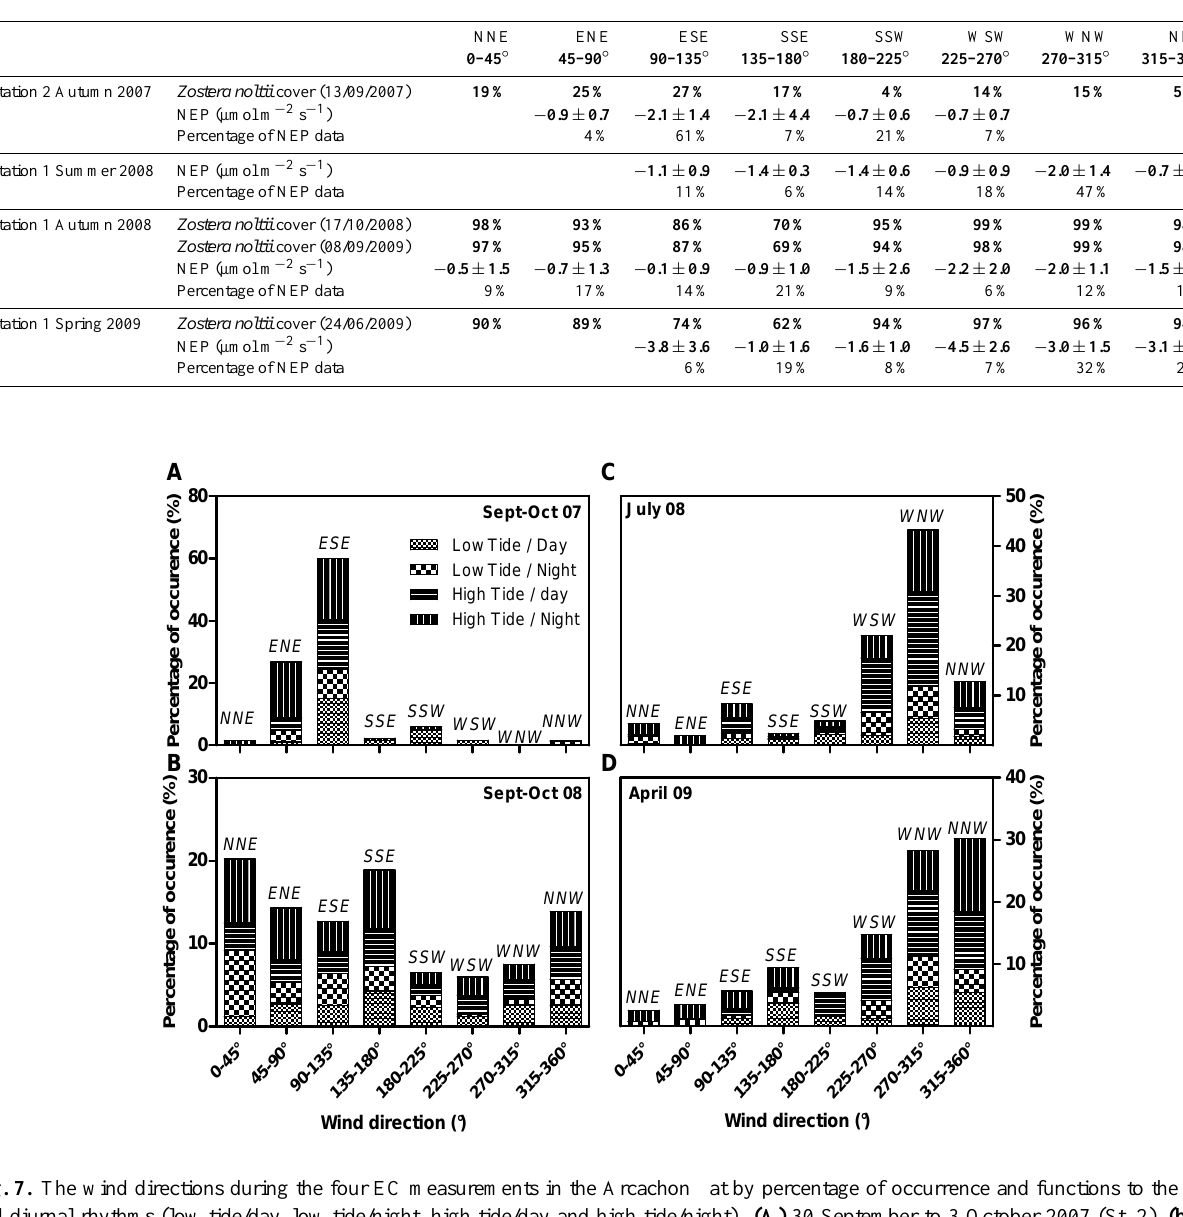
Table 2. NEP values (corresponding to mean LT/Day CO 2 fluxes ± standard deviation) and Zostera noltii covers derived from satellite image analyses from the Arcachon flat, at low tide during the day, according to sectors of wind direction (circle of 1000m radius around the mast and split in 32 sectors of 11.25 ◦ ). No satellite image matching with the deployment in July 2008 at Station 1 was available.